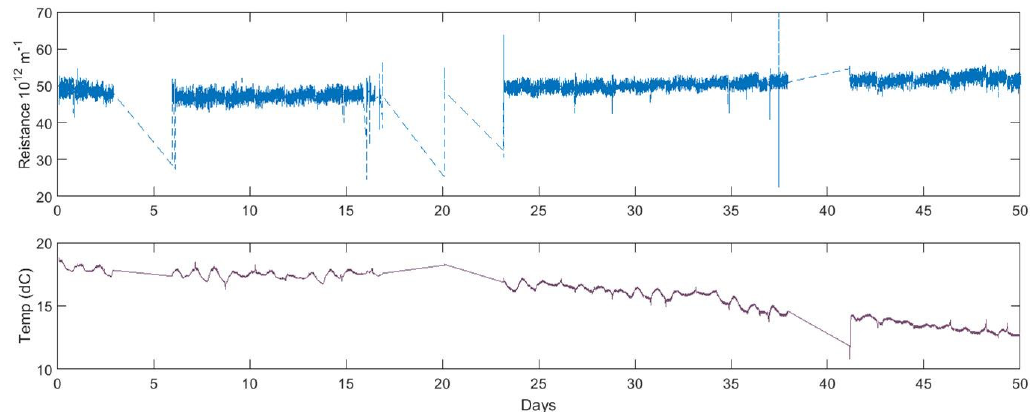
Figure 4. Total resistance (membrane and fouling, temperature corrected) of the HFNF for Lake Bolmen and feed water temperature from the start of the trial, flux 20 L/m 2 h (normalized flux varies, increases with time due to temperature decrease).